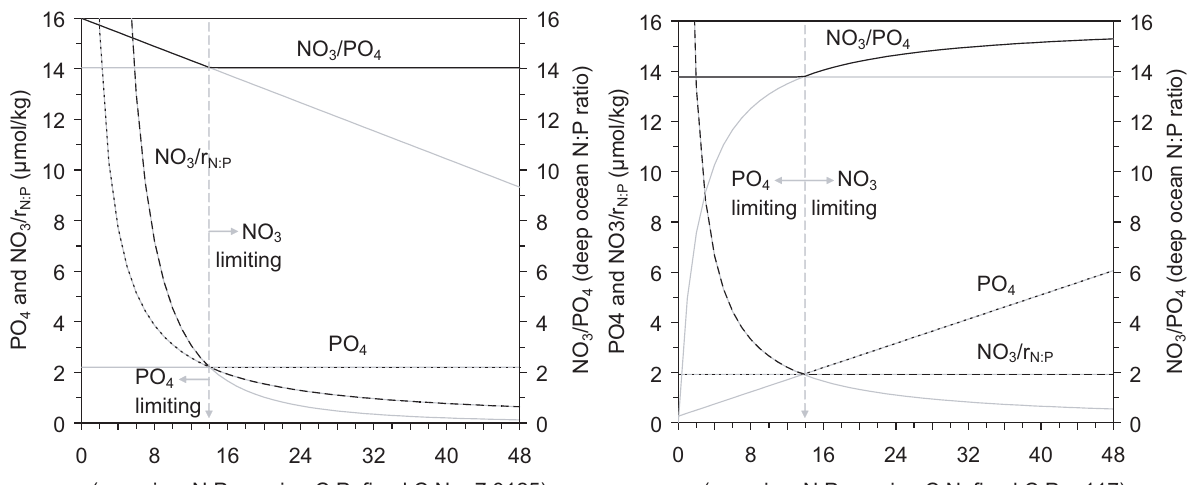
Fig. 4. Analytic solutions for the dependence of steady state PO 4 (dotted line), NO 3 / r N : P (dashed line), and deep ocean N:P ratio (solid line) on the N:P Redfield ratio ( r N : P ), when the N:P threshold for N 2 -fixation is fixed at r N : P , Fix =16, in the LW model. (a) Fixing the C:N Redfield ratio at r C : N =117/16=7.3125. Here in the N-limiting regime, deep ocean N:P=14.04, and a switch to PO 4 limitation occurs when r N : P ≤ 14 . 04. (b) Fixing the C:P Redfield ratio at r C : P =117. Here the switch to PO 4 limitation occurs when r N : P ≤ 13 . 77, and this regime has deep ocean N:P=13.77. Other details are as in Fig. 3.